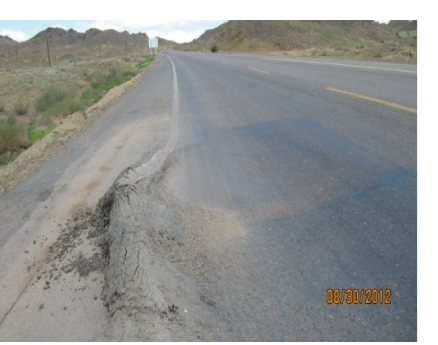
Figure 6: Shoving in southern Xinjiang in national highway no. 30 (Kumul